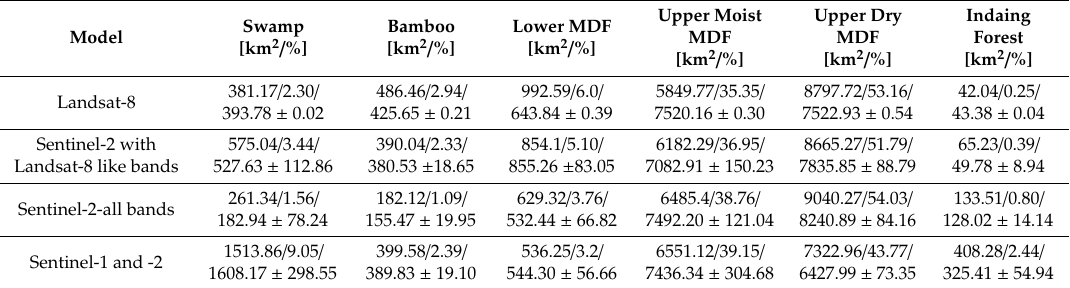
Table 3. Forest area estimates by di ff erent models in Bago Region, Myanmar. The values are in following order, absolute area estimated at pixel level, percentage of total area estimated at pixel level and area estimated with 95% confidence intervals. MDF: Mixed Deciduous